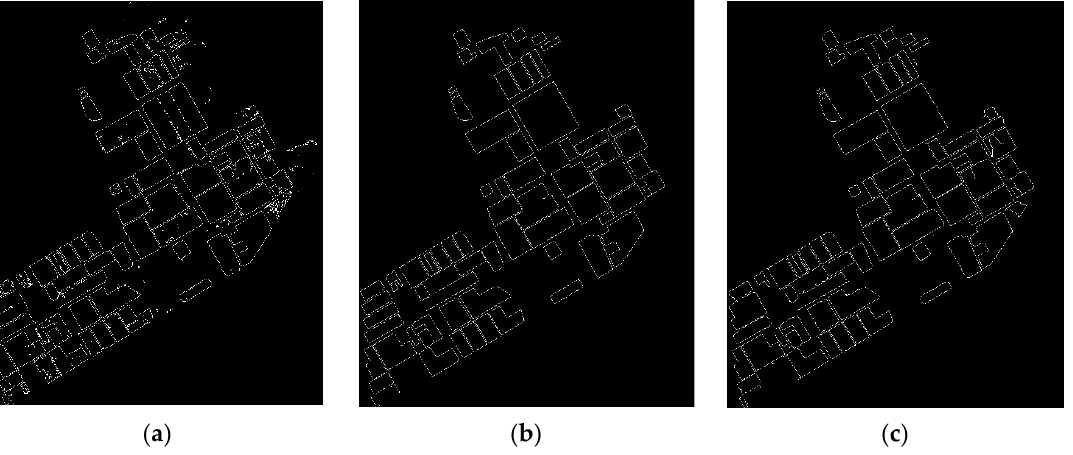
Figure 11. Field boundaries from ( a ) SAE, ( b ) GFSAE, and ( c ) ground truth for the CEF dataset.